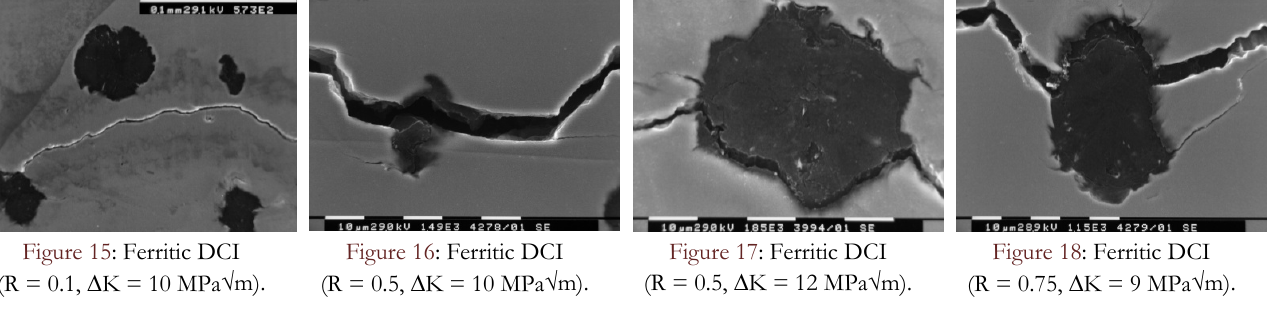
Figure 15: Ferritic DCI (R = 0.1,  K = 10 MPa √ m).